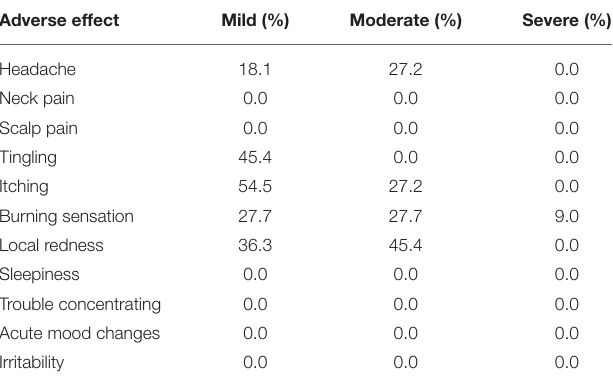
TABLE 2 | Percentage of adverse effects reported by